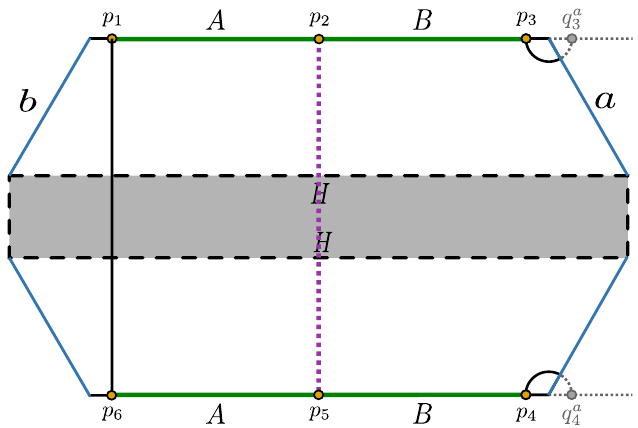
Figure 19 . The points in the two BCFT 2 copies are identified similarly as in figure